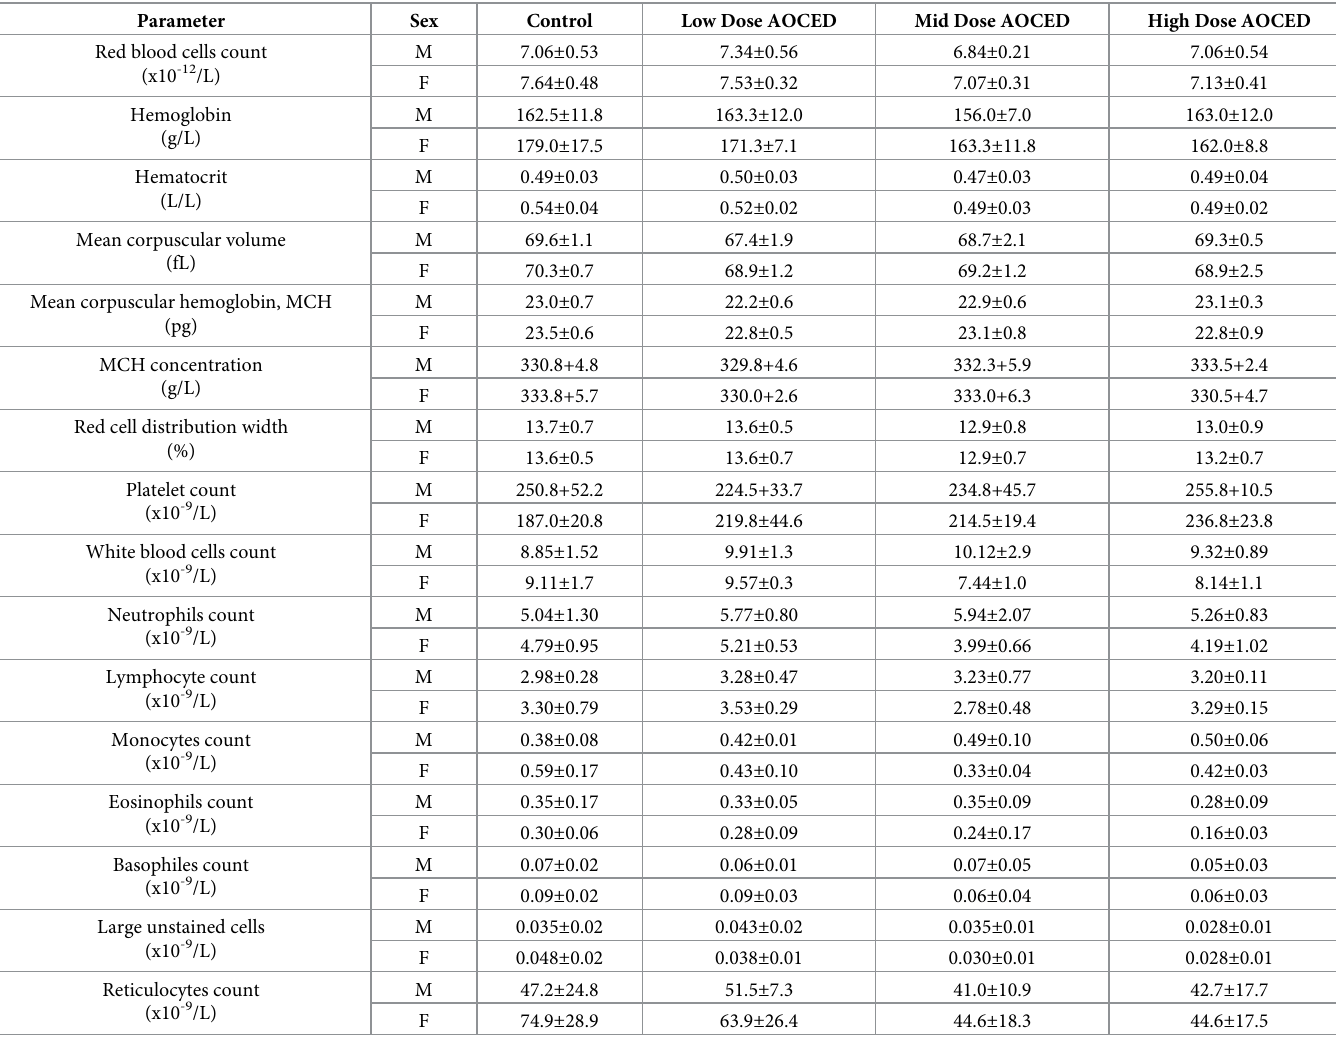
Table 5. Hematology values at study completion (PPD 224) following AOCED exposure starting in utero until puppies reach 6 months after